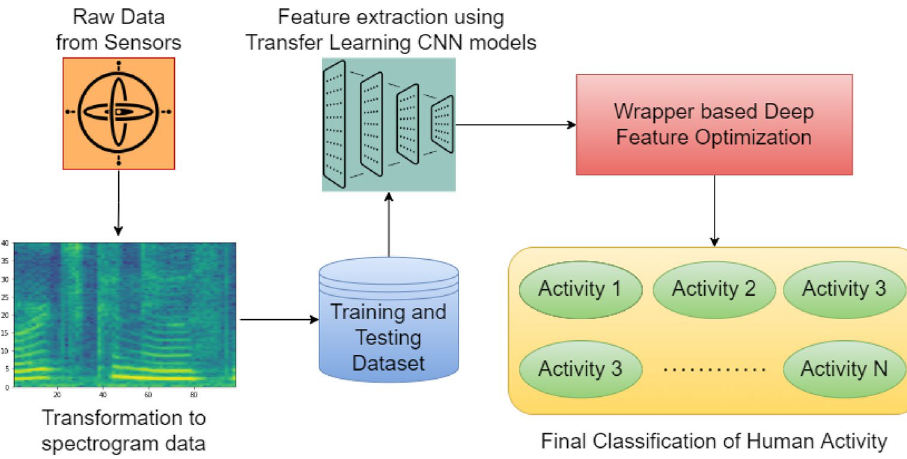
Figure 1. Graphical representation of the proposed wrapper-based deep feature optimization framework for HAR